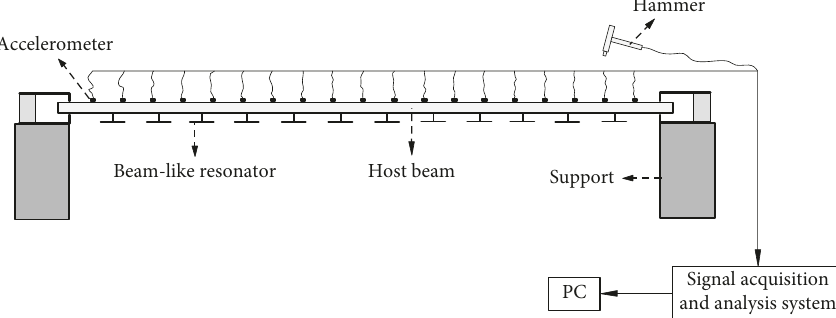
Figure 14: Schematic diagram of experimental system